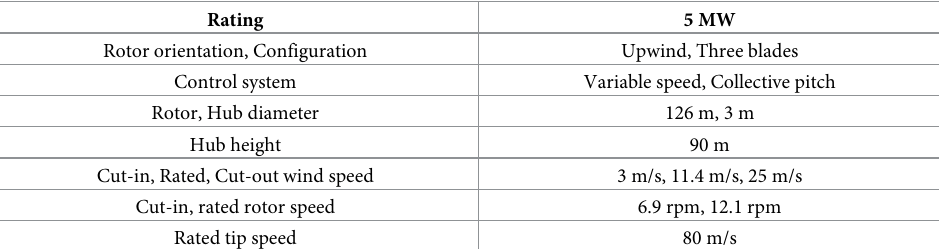
Table 1. Design and operating characteristics of the NREL 5-MW reference turbine